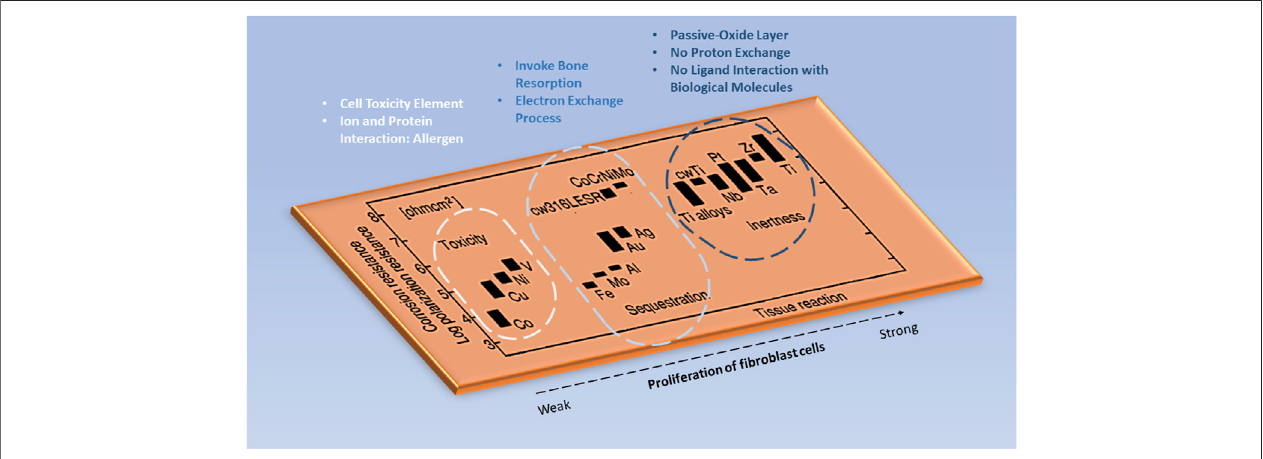
FIGURE 4 | The tissue responsive effect on various metallic elements in the implant. Image remodeled from Steinemann (1998).